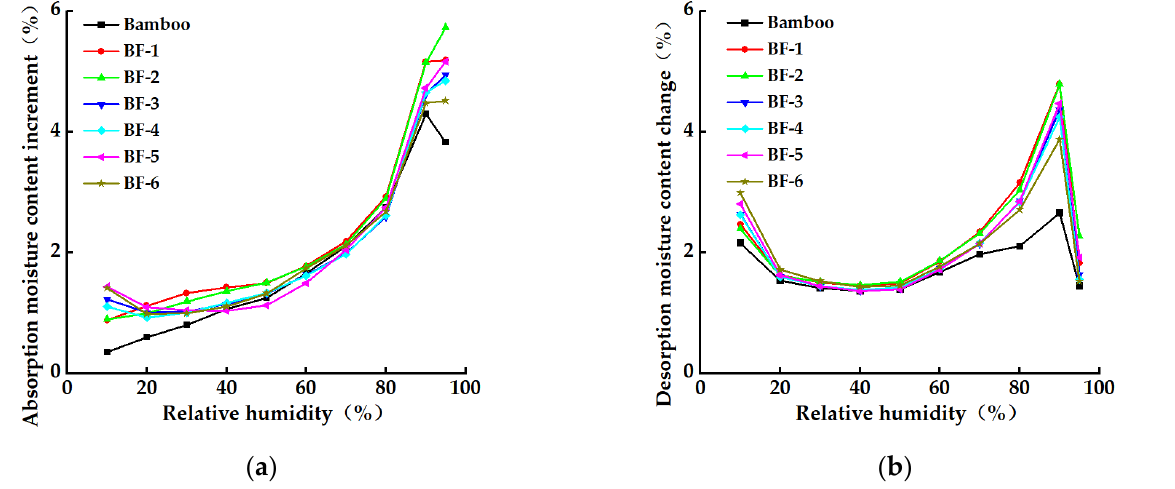
Figure 8. Water content change curve of bamboo fibers during water adsorption. ( a ) Change curve of absorption moisture content. ( b ) Change curve of desorption moisture content.